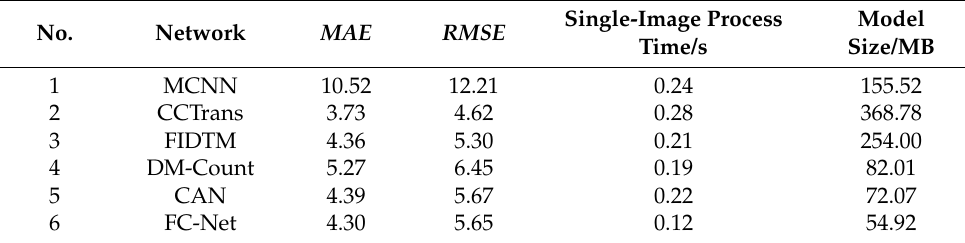
Table 3. Comparison with state-of-the-art networks for peach flower counting. No.